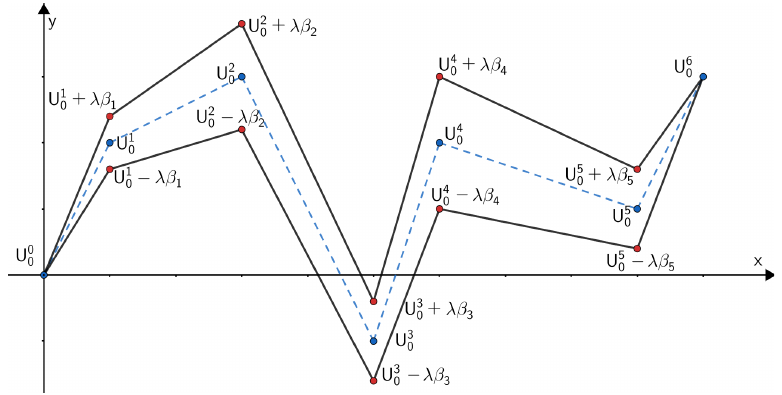
( λ , α , β ) of the function U Figure 4. The tube T U 0